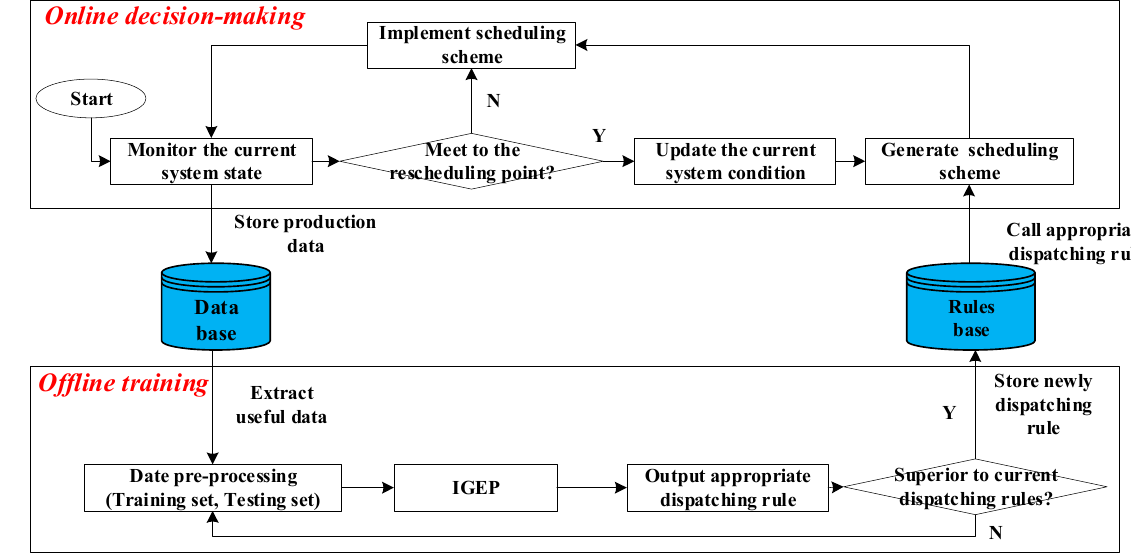
Figure 2. The framework of the proposed approach.